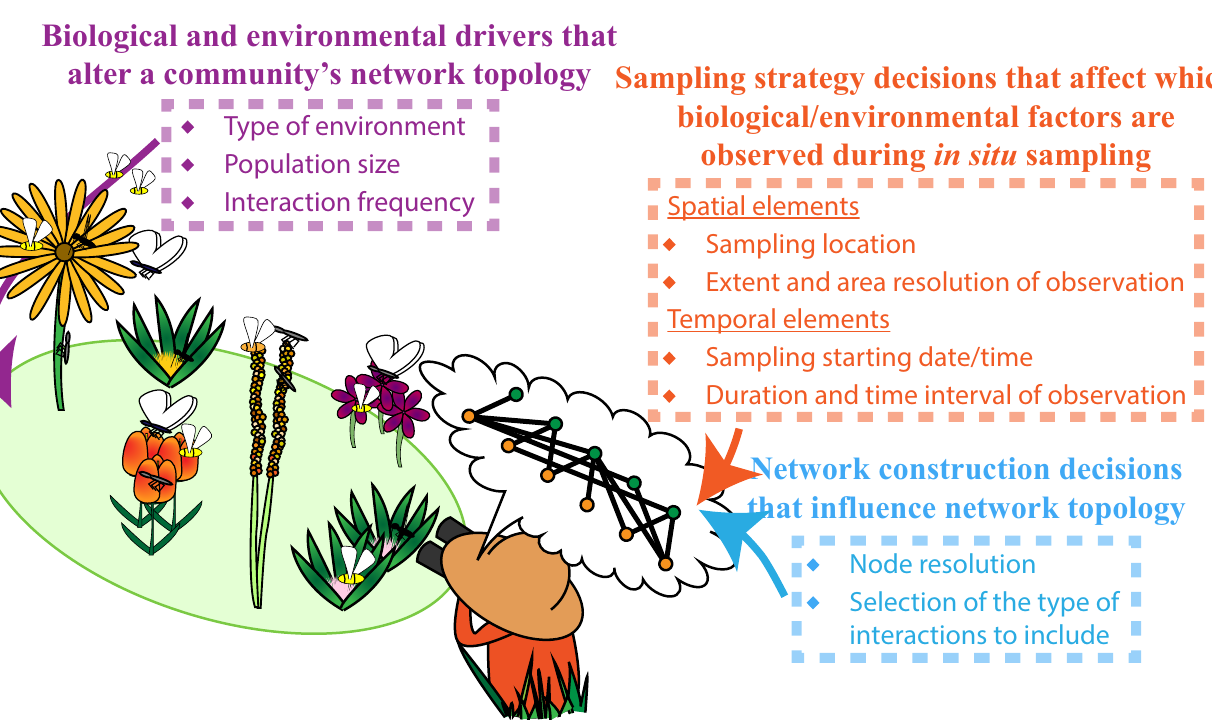
Fig 1. Potential sources of topological heterogeneity that influence researchers’ interpretation of a plant–pollinator community as a bipartite network. Here, the observed plant–pollinator community (green oval) is translated into a researcher’s network representation (thought bubble). Sources of topological heterogeneity between different researchers’ network interpretations of a community could be introduced from: (i) observing different biological and environmental drivers (purple text) that influence the community’s interactions, (ii) the different selected sampling strategies (orange text) that influence which biological and environmental factors are included during a researcher’s observation, and (iii) the different selected network construction methods (blue text) researchers use to design a species interaction